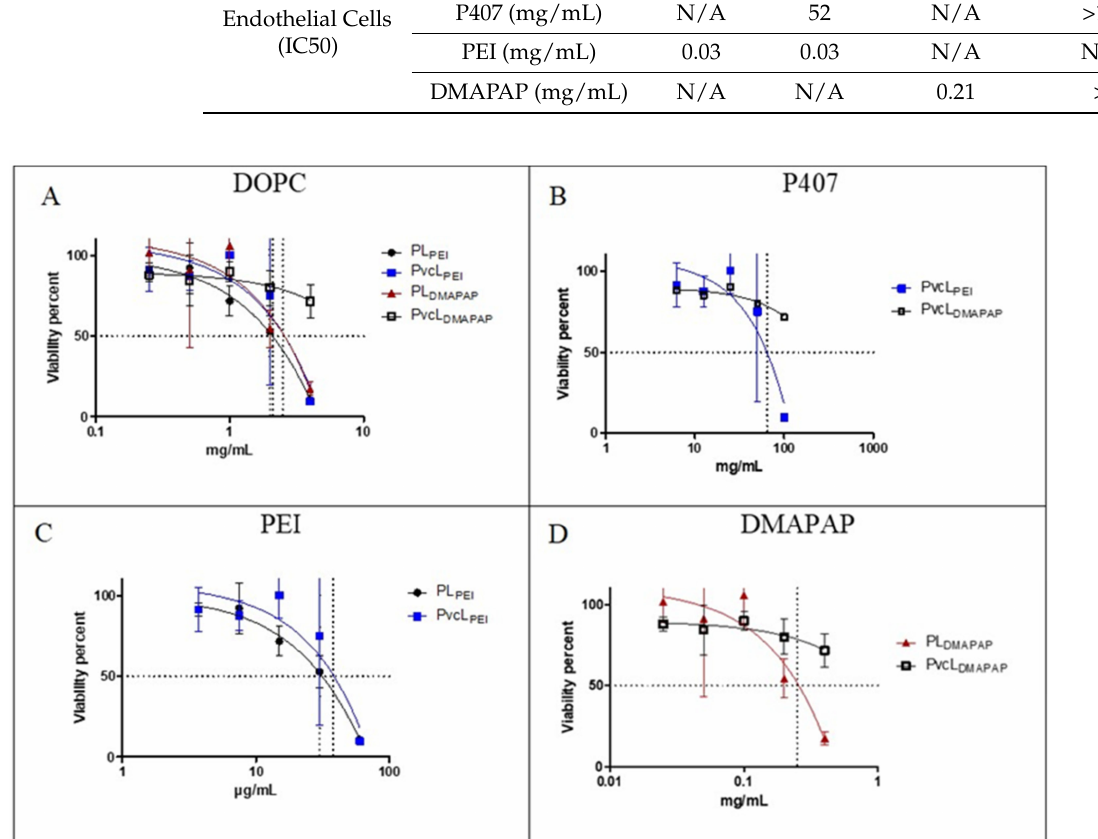
Figure 8. ( A ) DOPC, ( B ) P407, ( C ) PEI, and ( D ) DMAPAP concentration effects on EA.hy926 cell viability. Gaussian nonlinear regression fit and two-way ANOVA was applied p < 0.05 ( n =